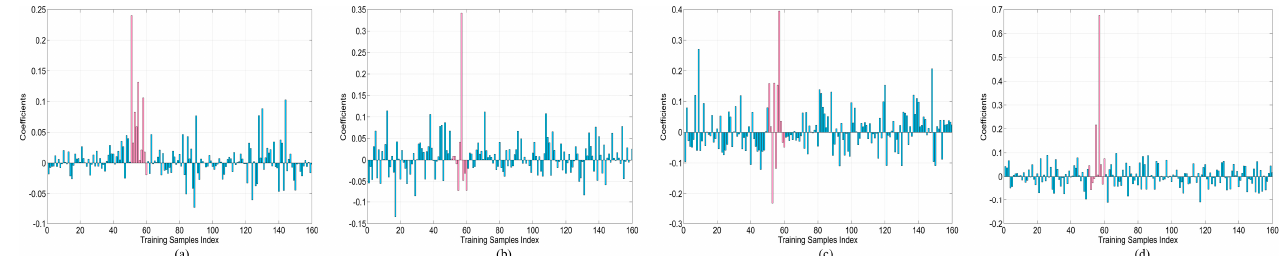
Figure 10. Representation coefficients of a test sample from class 6 in the Indian Pines data set using 10 training samples per class for the MFCARC algorithm. ( a ) Spectral. ( b ) Gabor. ( c ) Differential morphological profile (DMP). ( d ) Local binary pattern (LBP).